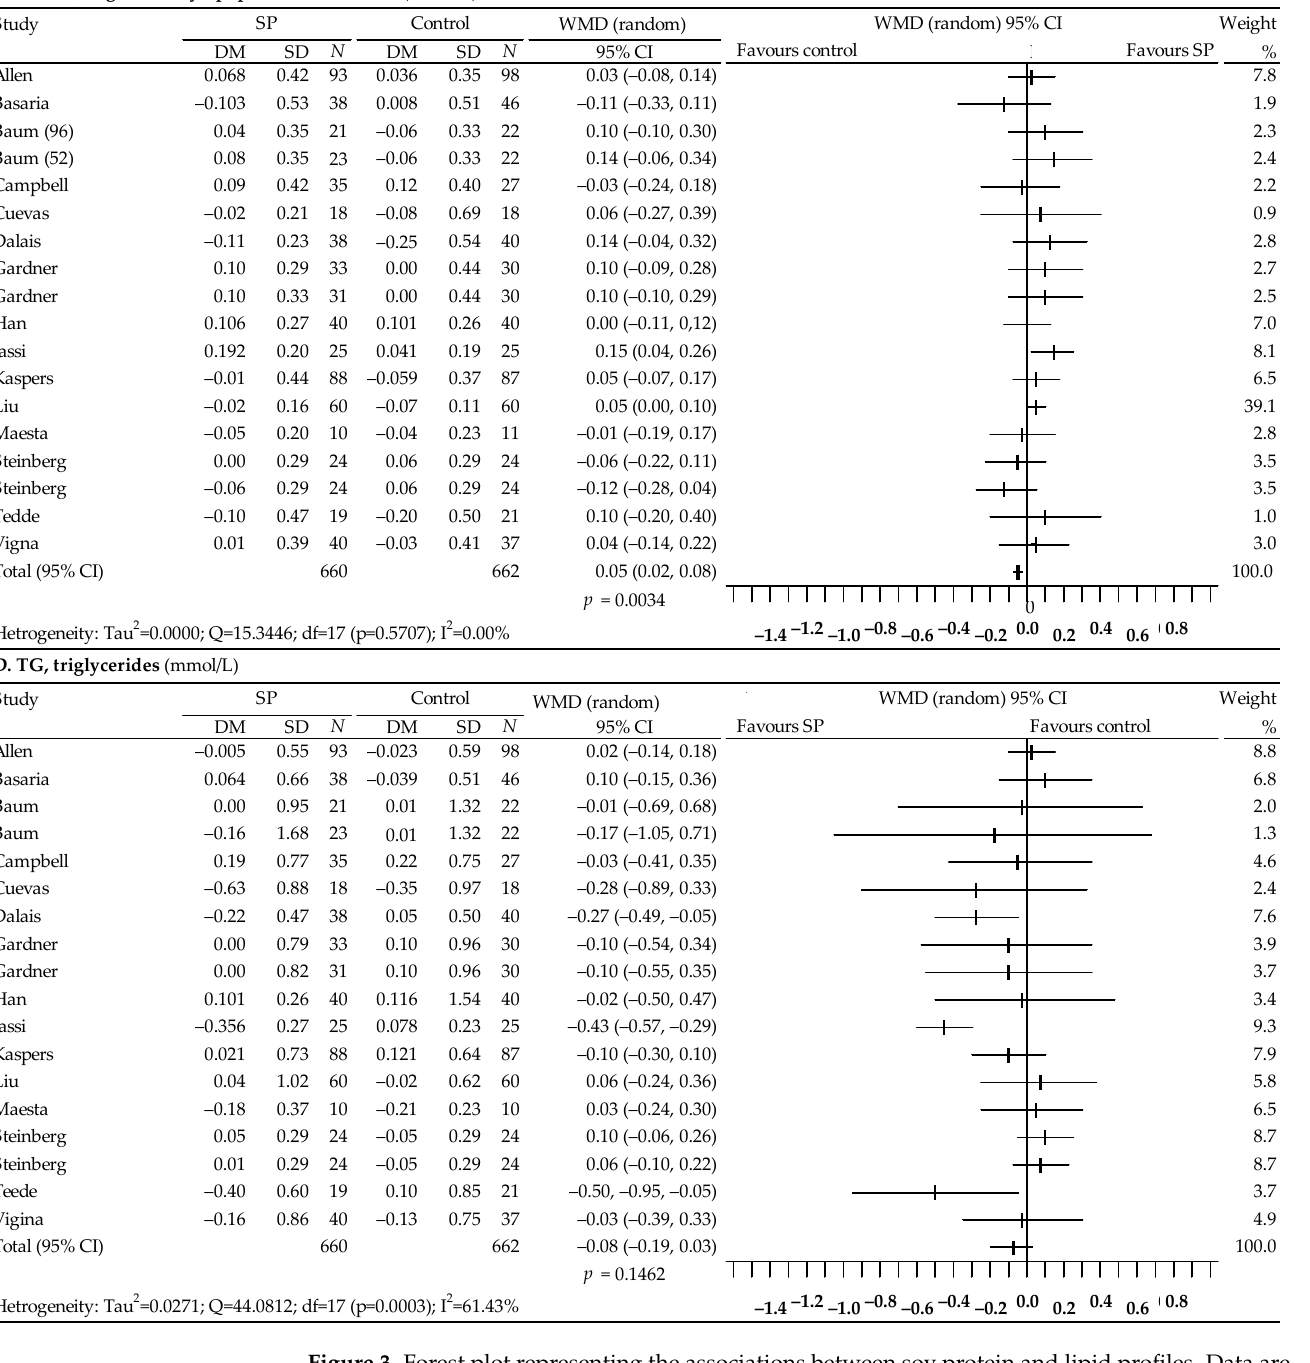
Figure 3. Forest plot representing the associations between soy protein and lipid profiles. Data are presented as weighted mean difference with 95% CI.